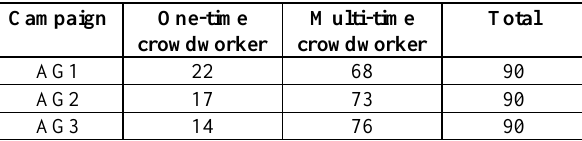
Table 5 . Number of crowdworkers in study A.